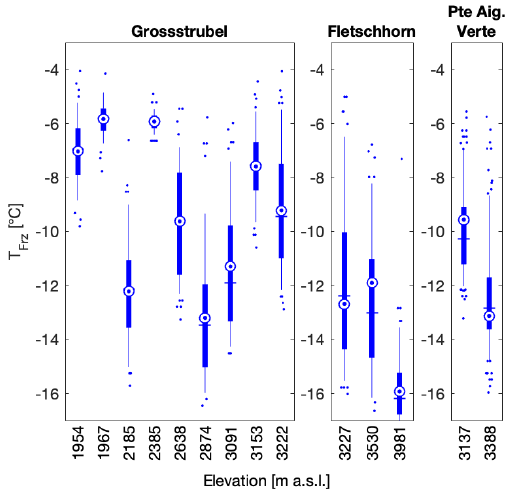
Figure 8. Snow samples were collected at different altitudes at Grossstrubel on 14 April 2018, at Fletschhorn on 22 April 2018 and at Pointe Aiguille Verte on 12 May 2018. In the boxplots, the blue vertical line shows the median and is equal to T 50 , the mean is shown as a blue circle with a concentric dot and the box ranges from the 25th to the 75th percentiles, and the whiskers extend from the 5th to the 95th percentiles. Note that the two Pointe Aiguille Verte boxplots contain 192 data points each as two individual snow samples were collected at the same location and thus combine for this